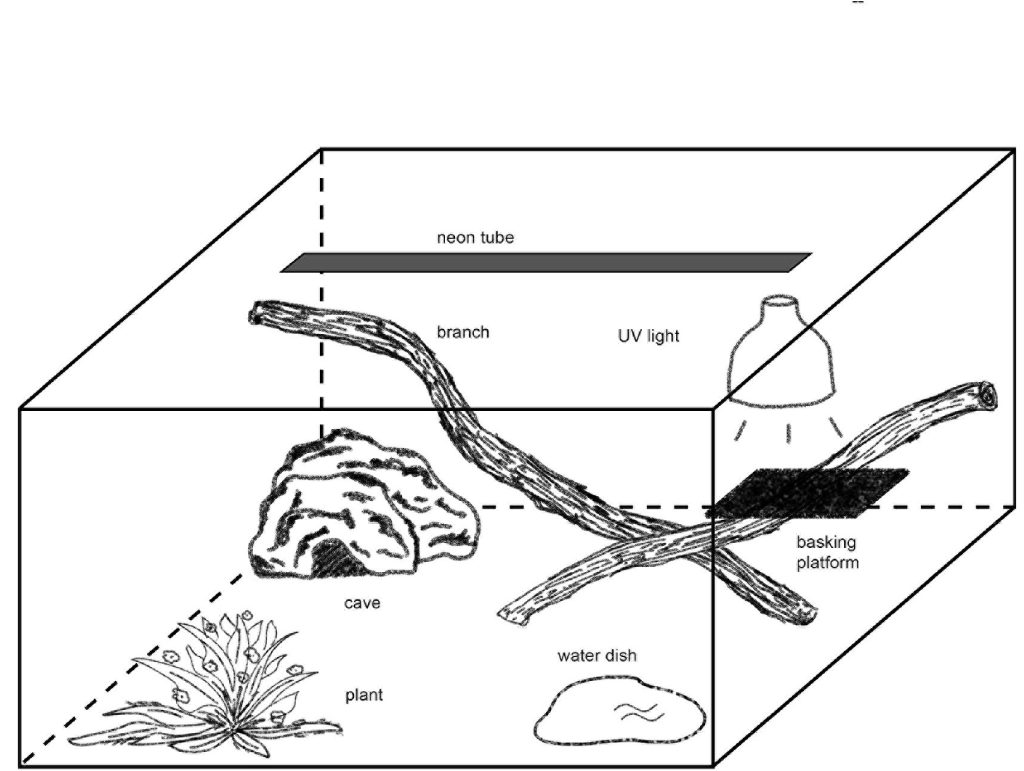
Fig 3. Schematic view of a terrarium. Housing in the terrarium. For housing the pythons in a terrarium (see Figs 3 and 4), three sizes of terrariums were used. They met the minimum requirements for housing reptiles [9]. The smallest terrariums measured 100 × 50 × 50 cm (LWH, Size 1), the medium-sized 120 × 60 × 60 cm (Size 2), and the largest 150 × 80 × 80 cm (Size 3). Basic illumination in all terrariums was provided via a fluorescent tube (Osram 865, 6500 Kelvin; Size 1: 18 W, Size 2: 30 W, Size 3: 36 W). For protection, the tube was installed in a moisture-proof bracket. As spotlight, we used a UV lamp (Size 1: Lucky Reptile Bright Sun UV Jungle 35 W, 34 cm above the basking platform; Sizes 2 and 3: Lucky Reptile Bright Sun UV Jungle 50 W, 39 cm above the basking platform) in a protective wire case (Lucky Reptile Thermo Socket plus Reflector). The temperatures during daytime (8:00 a.m. to 8:00 p.m.) were 38˚C underneath the spotlight and 25˚C in the coolest area. During nighttime, the measured temperature was on average 24˚C (22–26˚C). The substrate was a mixture of soil (60%), sand (20%), bark mulch (15%), and loam powder (5%). In the back half, the substrate was raised to a height of 35 cm to enable the snakes to burrow. The average substrate thickness in the front half was 10 cm. Each terrar- ium had a hiding place like the one used in the rack system and an elevated basking platform underneath the UV lamp. Furthermore, each terrarium contained a water basin and a living plant, which was held in place by a layer of gravel. The remaining furnishings included trunks, branches, twigs, clumps of grass, roots, moss, rocks, and bark and had been collected outdoors. The arrangement of the furnishings was identical, but the use of natural materials did not allow a 100% match. For video recordings, each terrarium was illuminated with a single red LED bulb (650 nm) that was controlled with a timer.